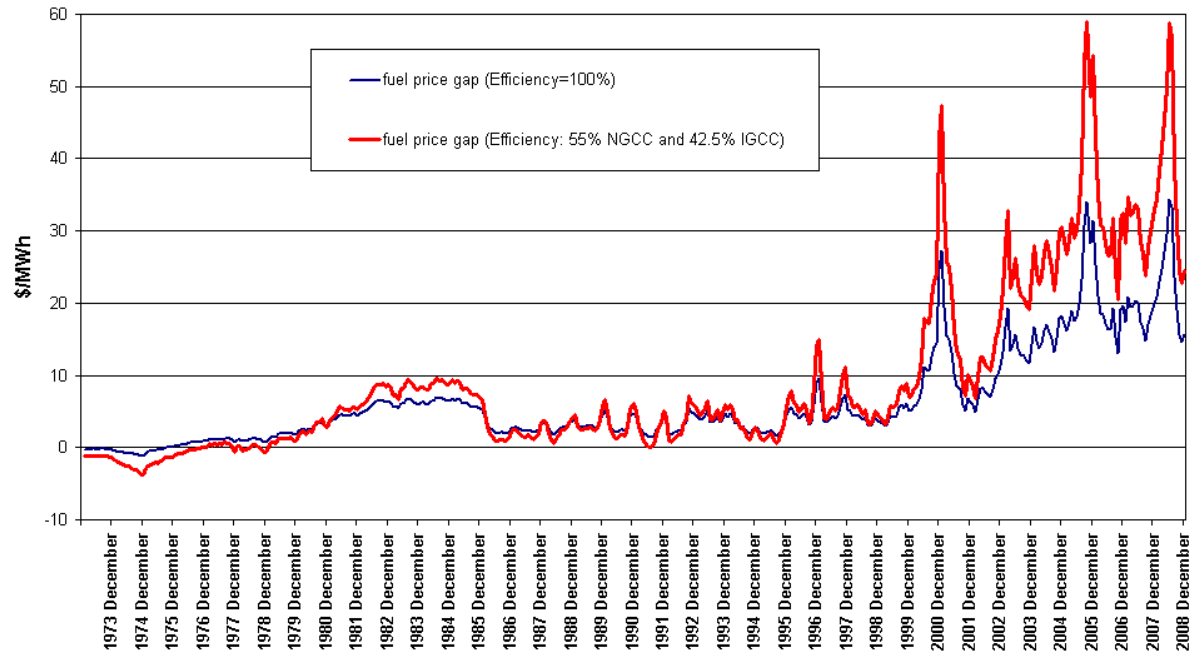
Figure 4. Fuel price gap between natural gas and